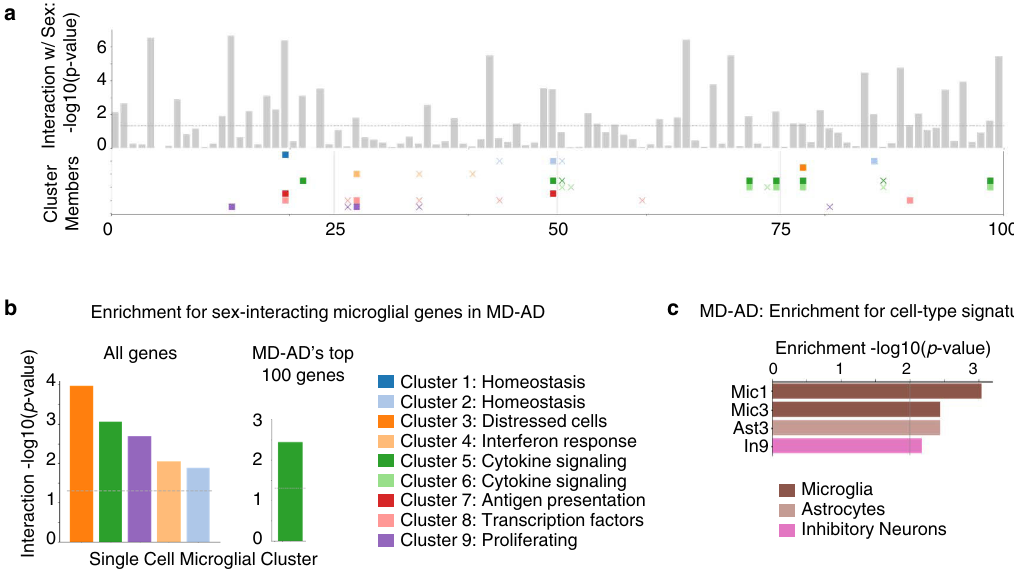
Fig. 6 MD-AD ’ s reliance on microglial cluster genes and cell type signatures. a Bars indicate the gene ’ s − log10( p value) of the interaction term with sex (after FDR correction), and gene membership in microglial cluster gene sets from Olah et al. 38 is indicated below. A fi lled square indicates that the gene signi fi cantly interacts with sex ( p < 0.05 after FDR correction), and an “ x ” marker indicates that it does not. b For genes with signi fi cant sex interactions, we compute the signi fi cance of the overlap between microglial cluster genes and sex-differential genes among: left: all genes, and right: the top 100 MD-AD genes only. c Gene set enrichment − log10( p value) across the fi nal MD-AD gene ranking for cell type signatures 8